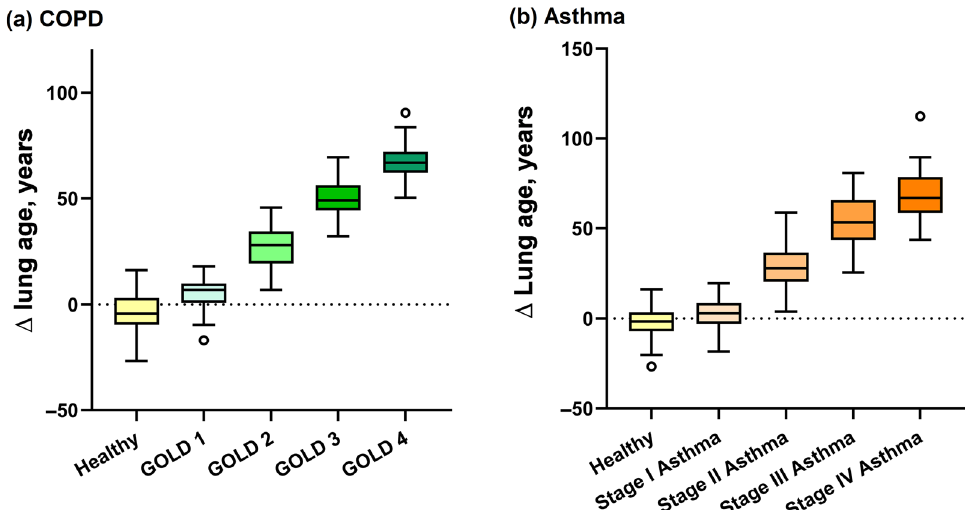
Fig. 4 Comparisons of Δ lung age between matched healthy subjects and patients with COPD and asthma. Stage I, 80% ≤ FEV 1 %pred; Stage II, 50% ≤ FEV 1 %pred <80%; Stage III, 30% ≤ FEV 1 %pred <50%; Stage IV, 30% >FEV 1 %pred. The centre line in the box indicates the median, the lower and upper bound of the box and whiskers indicate the fi rst and the third quartile, and the minimum and maximum value, the point indicates the